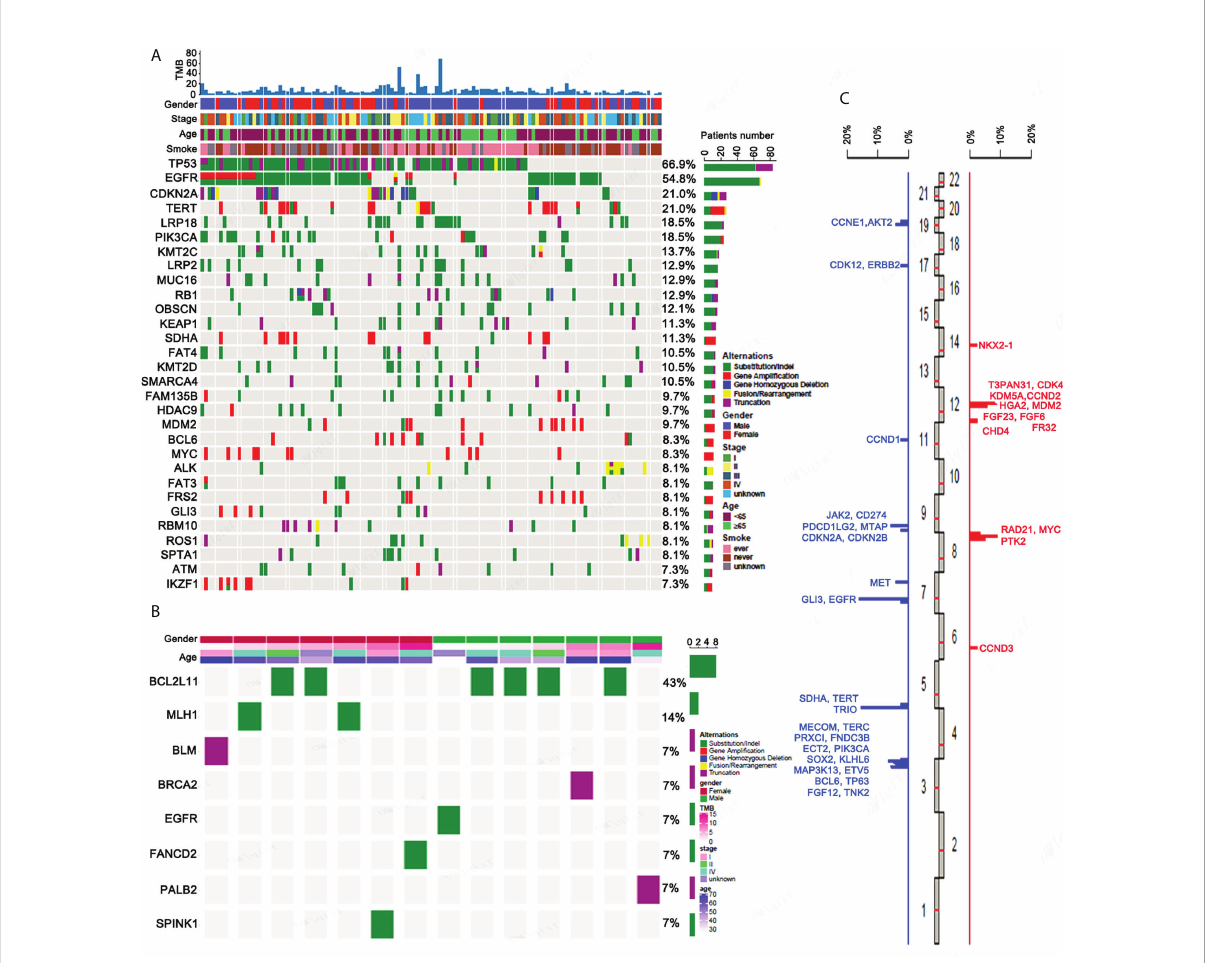
FIGURE 1 The genetic mutation pro fi les of ASC patients. (A) The top 30 somatic mutational genes containing different forms of mutations as well as their frequencies. (B) All germline mutational genes containing different forms of mutation as well as their frequencies. (C) The distribution of CNVs on